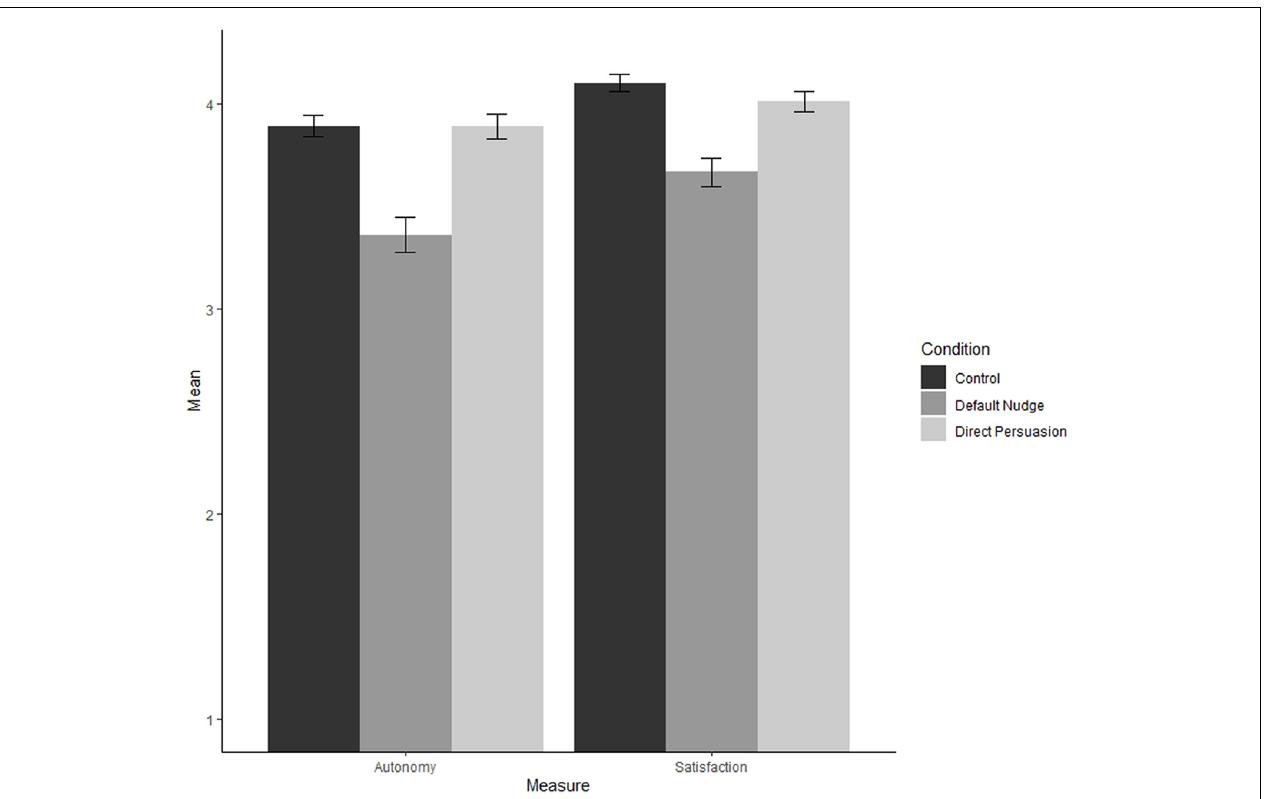
FIGURE 1 | Autonomy, competence, and satisfaction per condition (Study